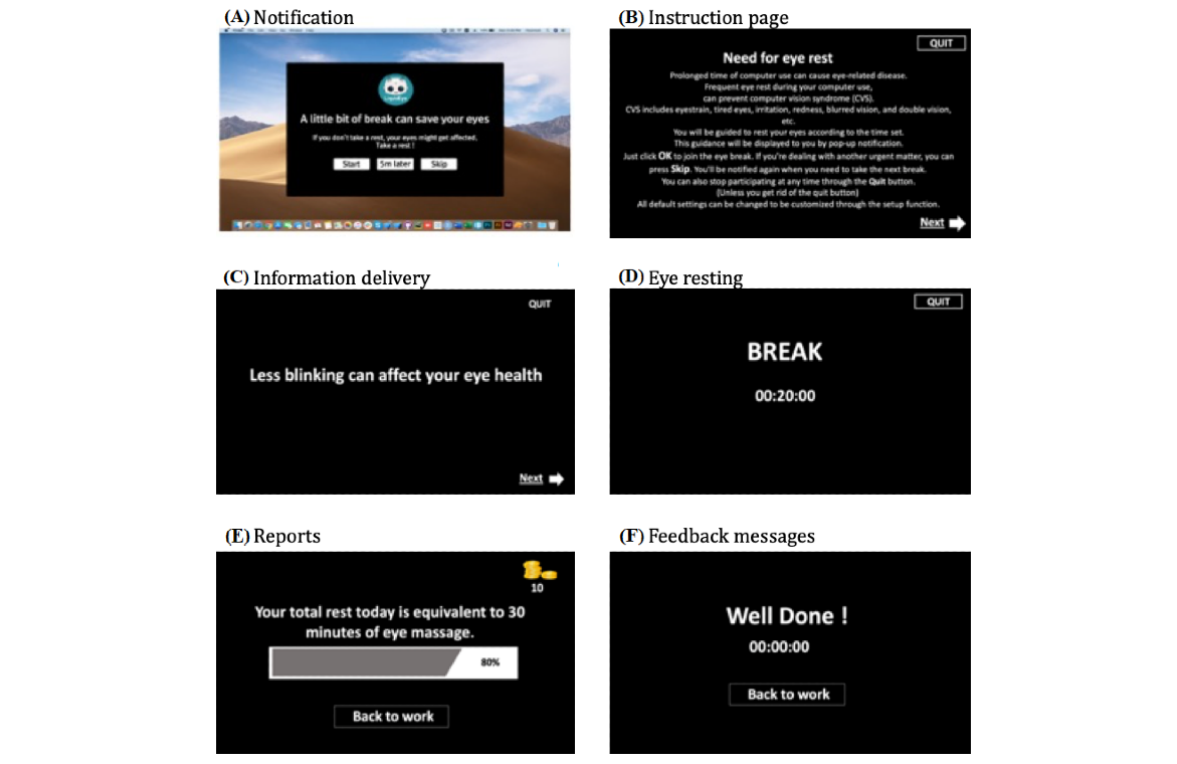
Figure 2. Example scenarios of LiquidEye. The interface elements (A-F) in the example scenarios are customizable in the settings